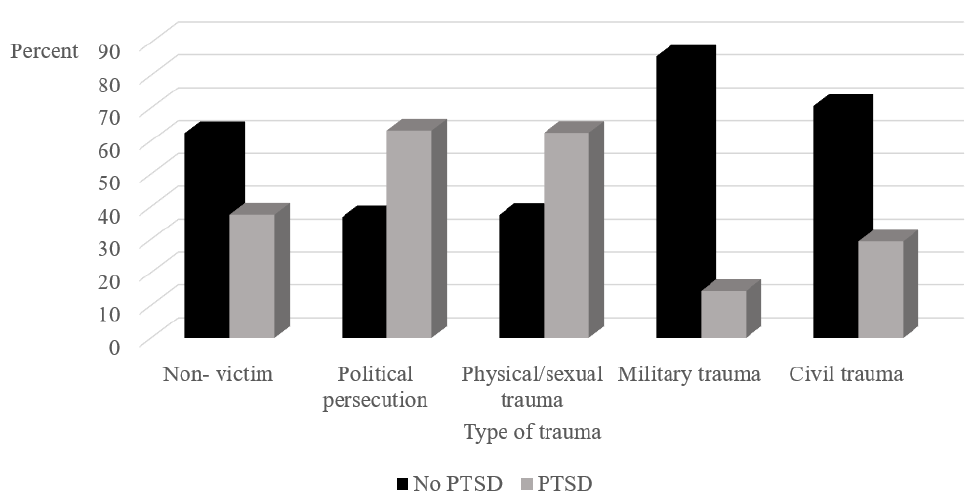
Figure 3. Percentage of asylum seekers with and without PTSD across different types of trauma in country of origin. PTSD = Post-traumatic stress disorder. country of origin. PTSD = Post-traumatic stress